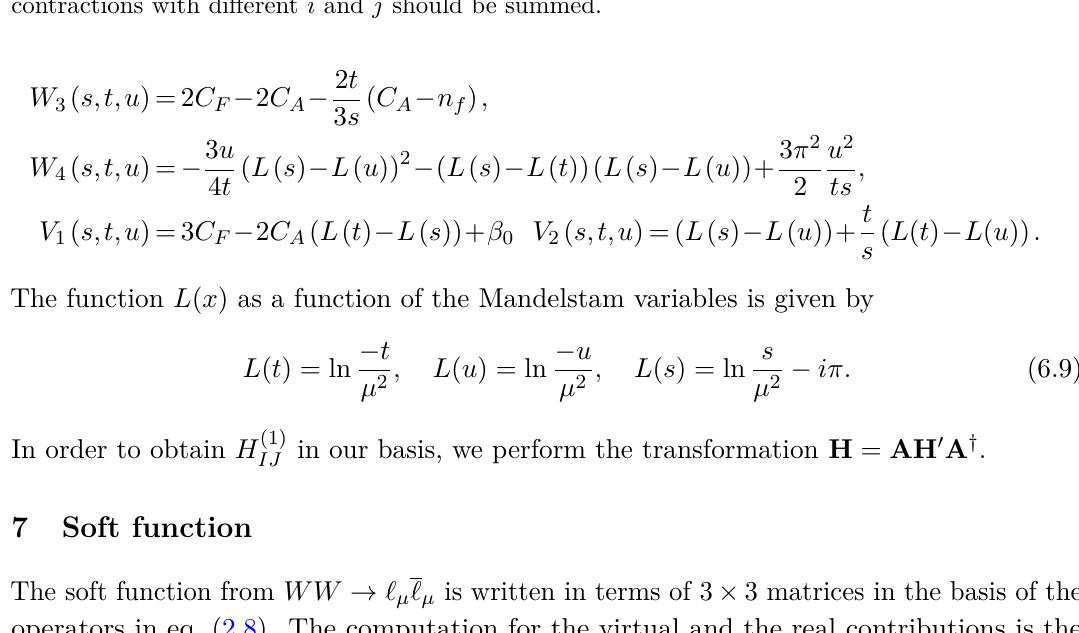
= 0 . All the possible pairs of i